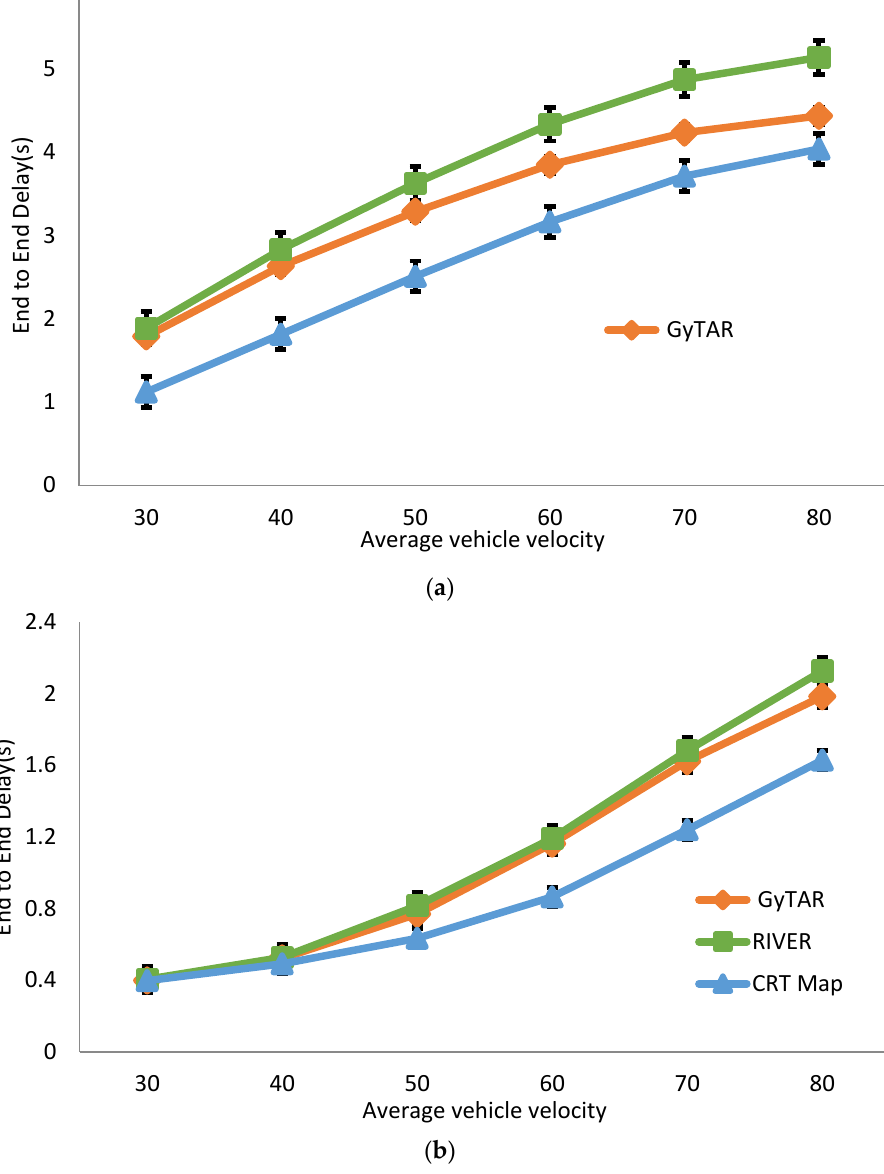
Figure 7. End-to-end delay vs. moving speed: ( a ) 100 vehicles; and ( b ) 300 vehicles.